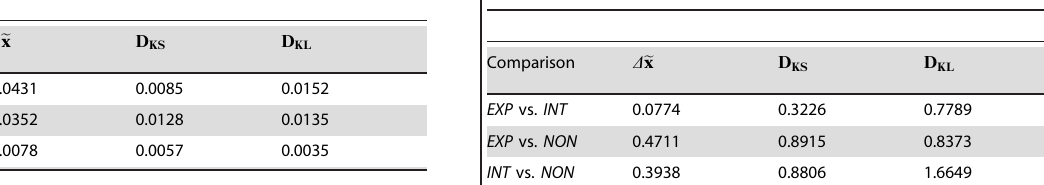
Table 2. Measures comparing cumulative distributions of angle to nearest neighbor w in experiment ( EXP ), a social interaction model ( INT ) and a noninteracting control model ( NON ). Comparison D e xx D KS D KL EXP vs. INT